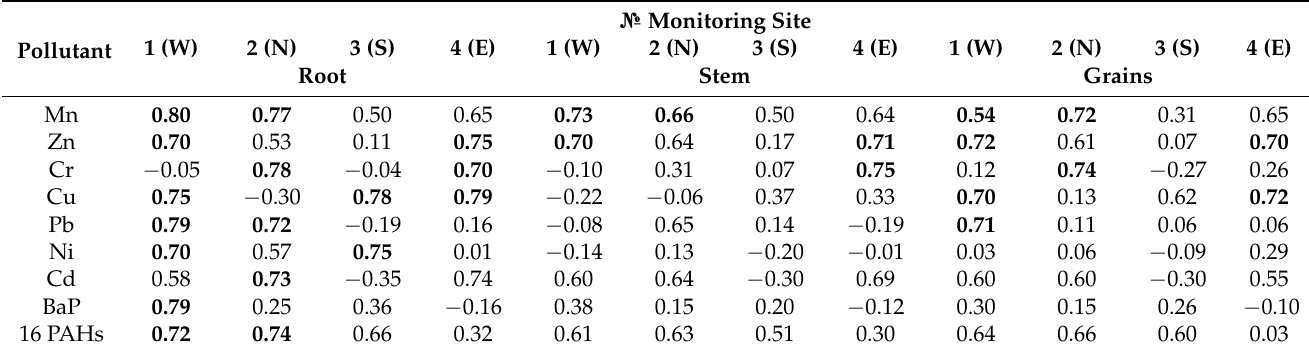
Table 5. Relationship between pollutant uptake during plant growth and the duration of pollutant